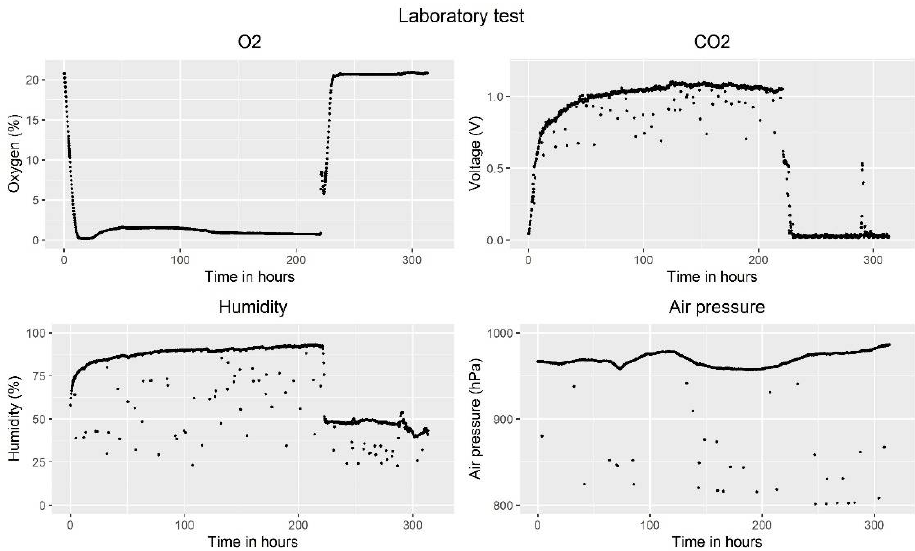
Figure 6. Laboratory test in a mason jar with green grass material. O 2 curve shows an increase after reaching zero already. CO 2 rises constantly, as well as humidity. Air pressure is not influenced by the ensiling process. When opening the jar after 221 h, O 2 , CO 2 and humidity show clear break- downs.